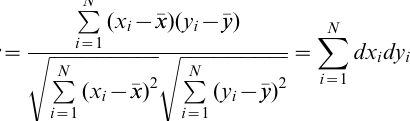
ffiffiffiffiffiffiffiffiffiffiffiffiffiffiffiffiffiffiffiffiffiffiffi P N